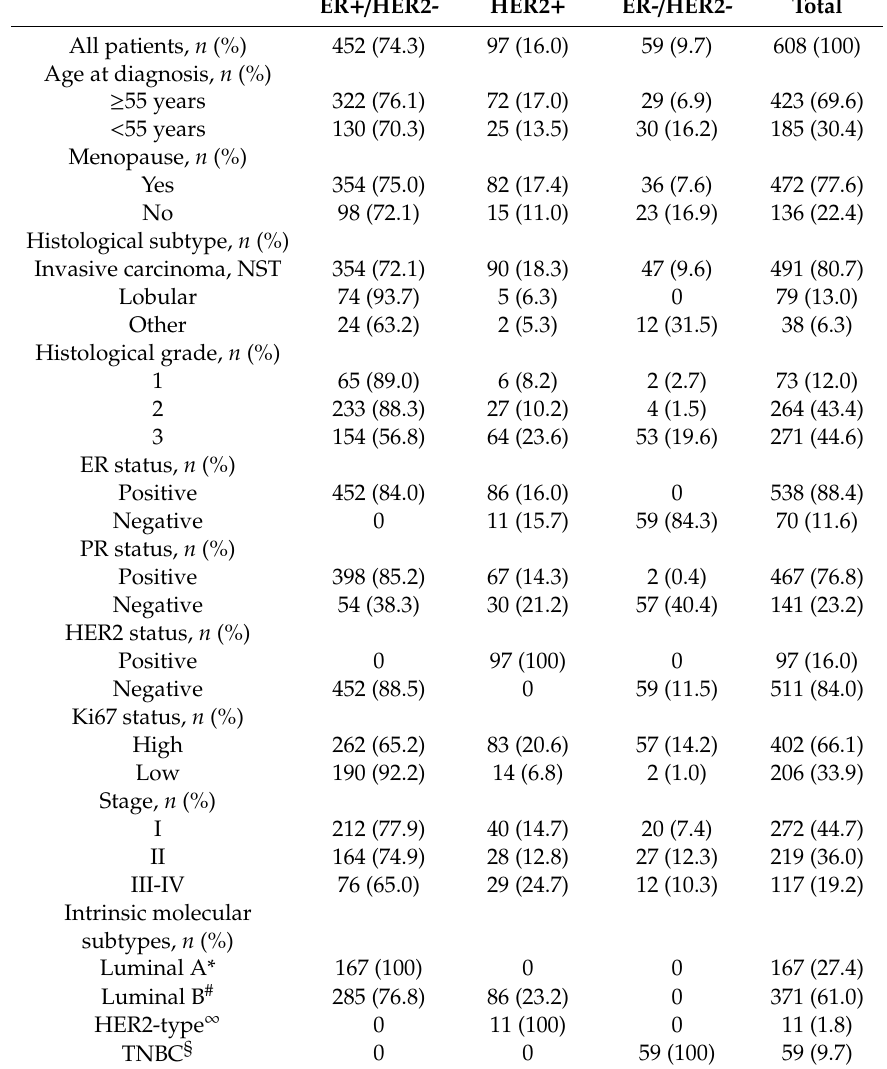
Table 6. Clinicopathologic features of the patients included in this study according to their biomarker status. All cases were re-classified, re-graded, and re-assessed for hormone receptor, Ki67, and HER2 status according to the latest guidelines. NST, no special type; TNBC, triple-negative breast